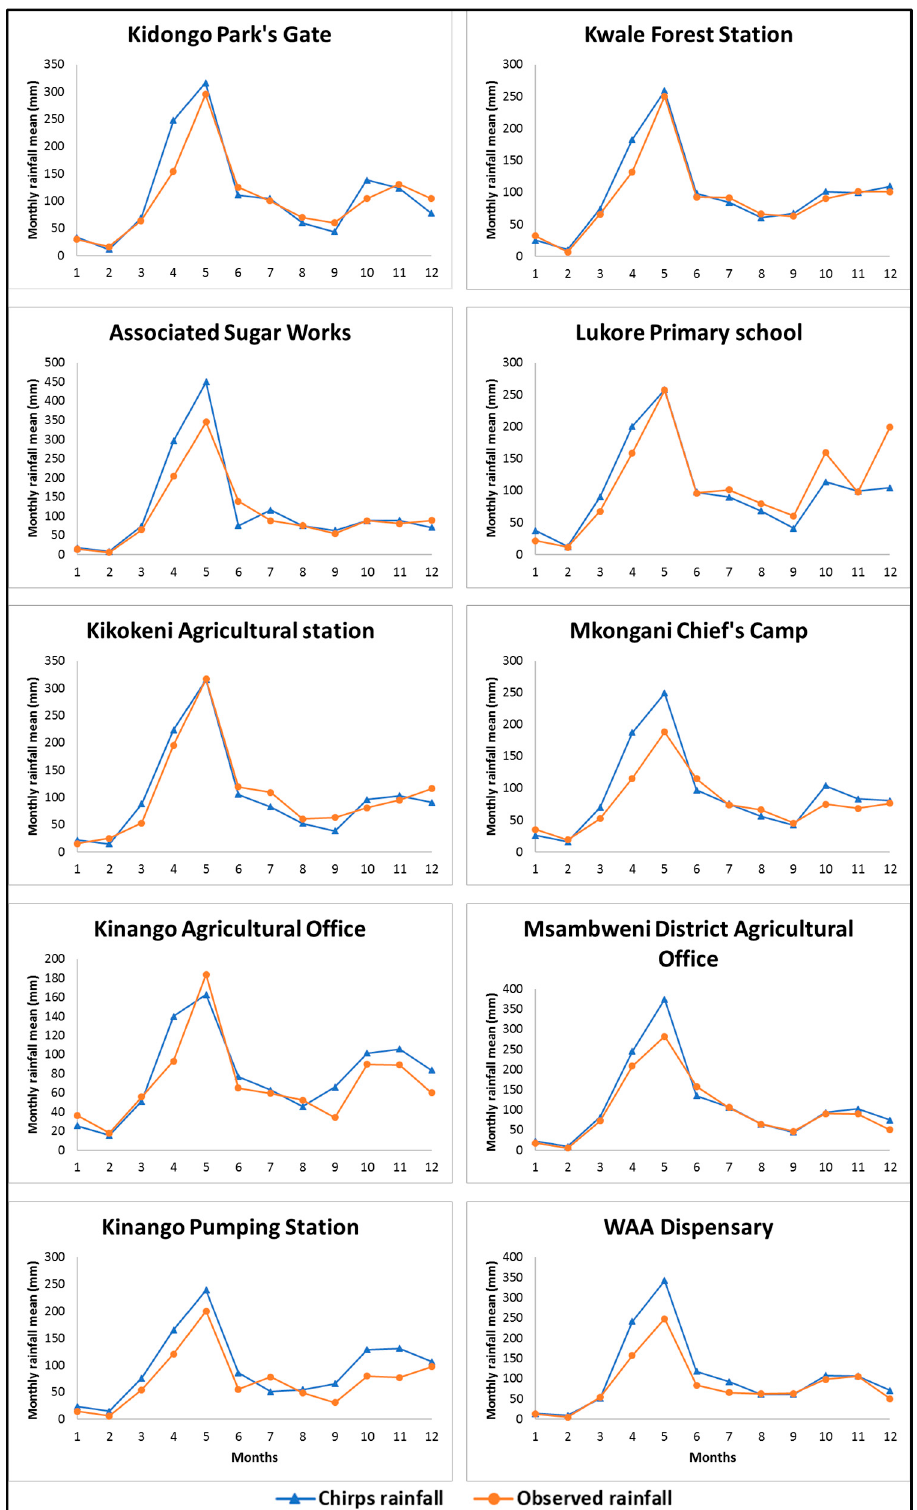
Figure 7. Comparison of CHIRPS and observed rainfall based on mean monthly distribution .